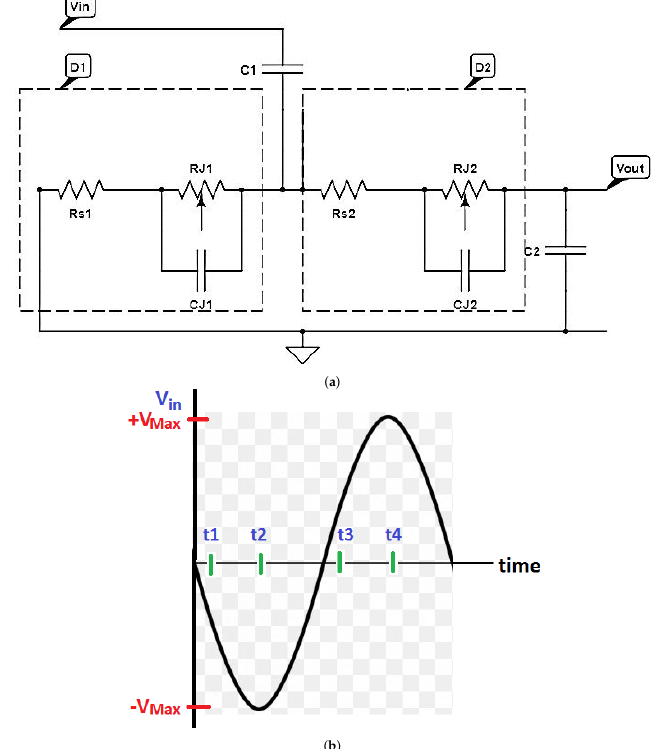
( b ) Figure1. ( a )Equivalentcircuitofasingle-stagevoltagedoublercircuit. ( b )AsinglecycleoftheappliedRFwavetothe voltagedoubler. Figure 1. ( a ) Equivalent circuit of a single-stage voltage doubler circuit. ( b ) A single cycle of the applied RF wave to the voltage